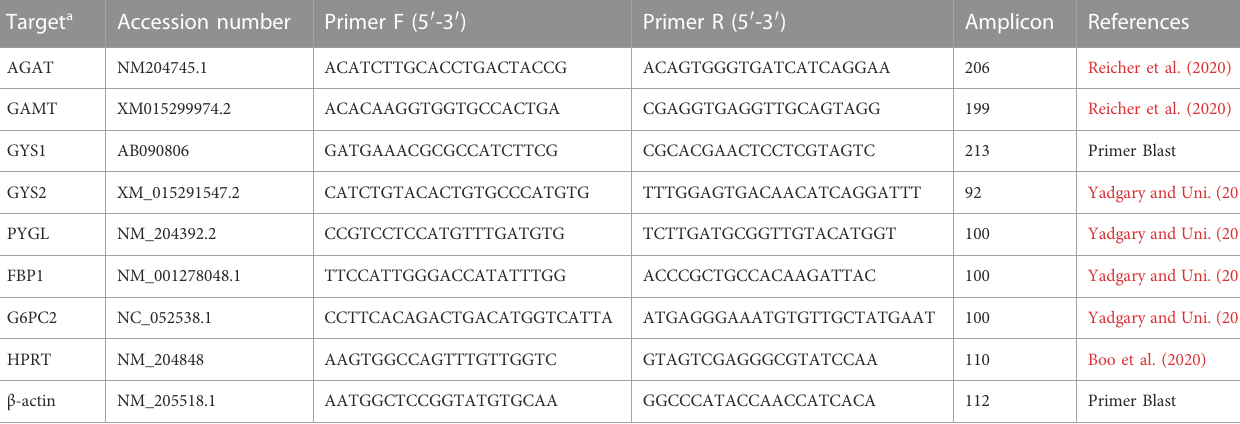
TABLE 1 Primers used for real-time PCR gene expression